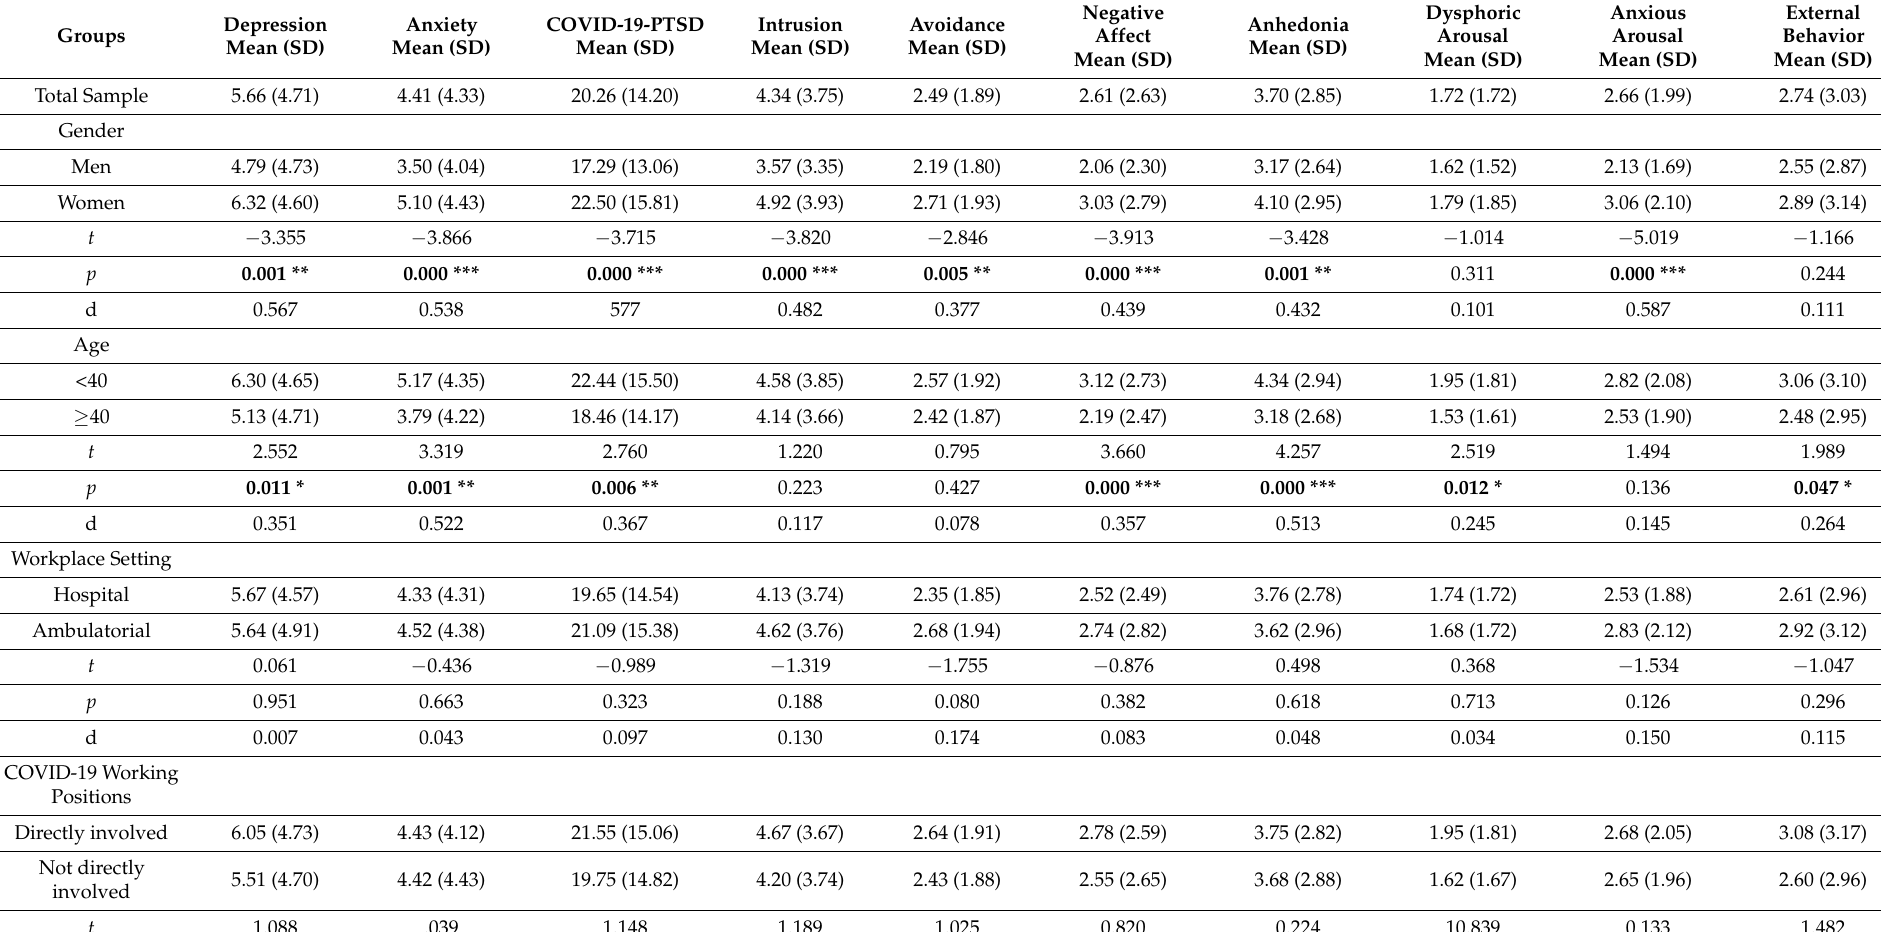
Table 4. Differences between Groups (Student’s t -Test, ANOVA One Way). Clinical Variables: Depression; Anxiety; COVID-19—PTSD. COVID-19—PTSD Mechanisms measured as subscales of COVID-19 PTSD Questionnaire: Intrusion, Avoidance, Anhedonia, Dysphoric Arousal, Anxious Arousal, External Behavior.